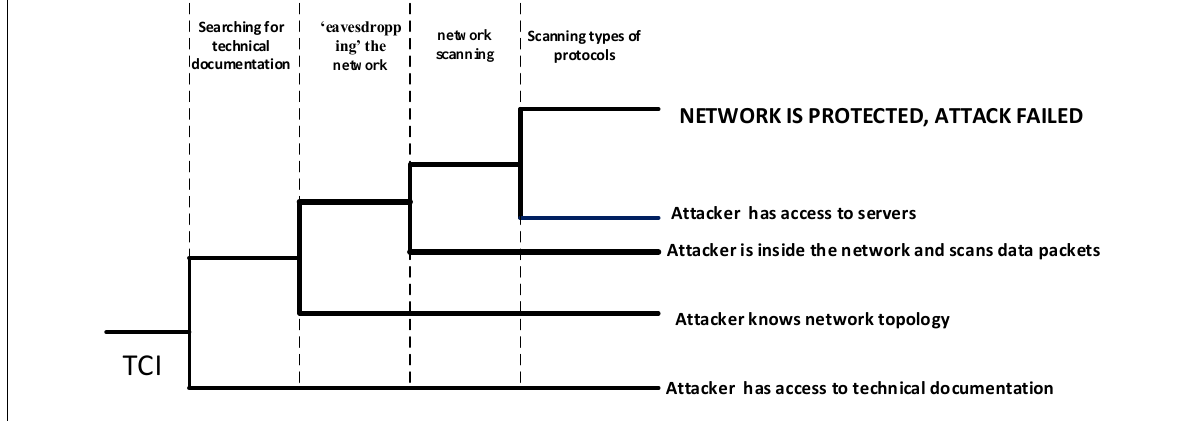
Fig. 3. An event tree for a cyber attack “Technical Computer Intelligence”